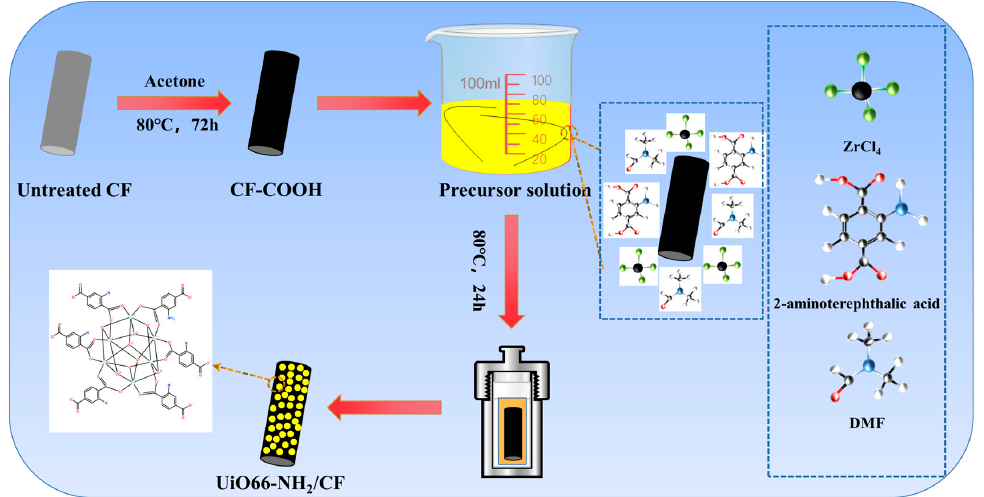
Figure 1. Illustration of the manufacturing process of MOF/CF multi-scale